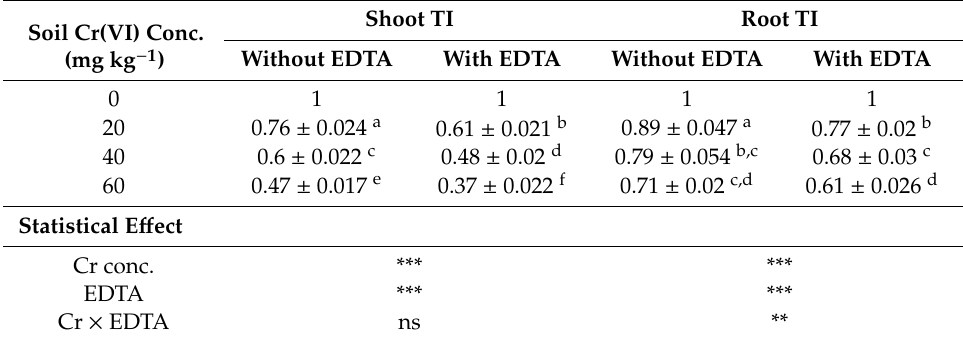
Table 3. E ff ects of various Cr(VI) concentrations in soil on tolerance indices (TI) of root and shoot of hybrid Napier grass with and without EDTA